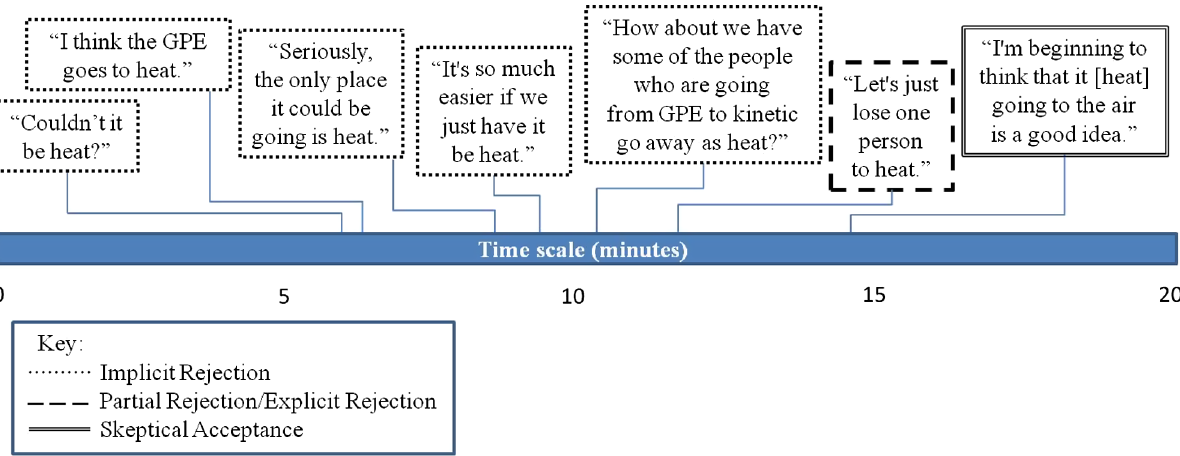
FIG. 3. A timeline displays the evolution of suggestions for thermal energy as a solution to the lowering